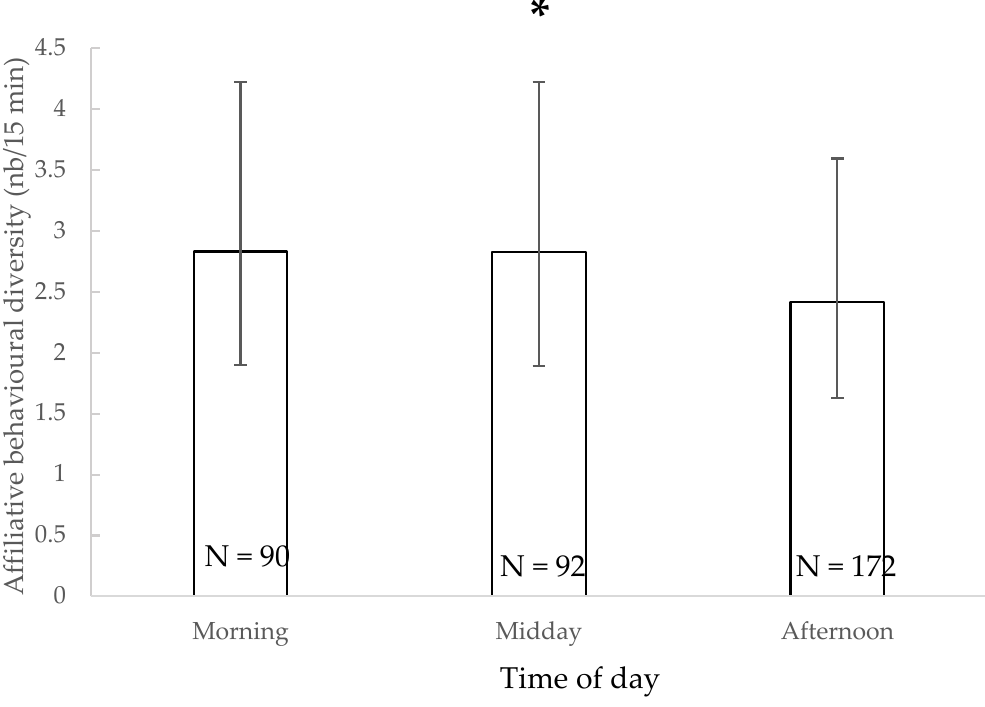
Figure 2. Mean of affiliative behavioural diversity and 95% confidence intervals according to the time of day. *: p < 0.05 (Wald chi-squared test). N: number of observations.